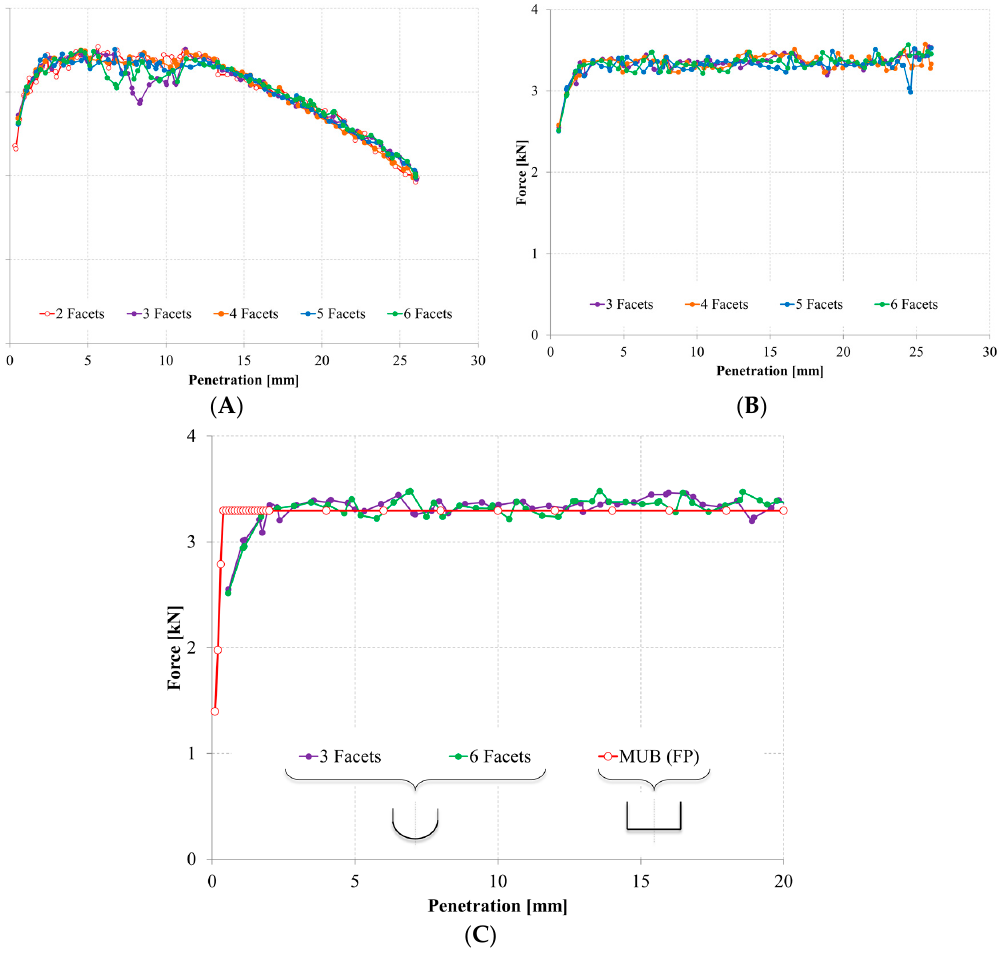
Figure 16. Geometry 4 results ( A ); detail ( B ); and MUB approach ( C ).